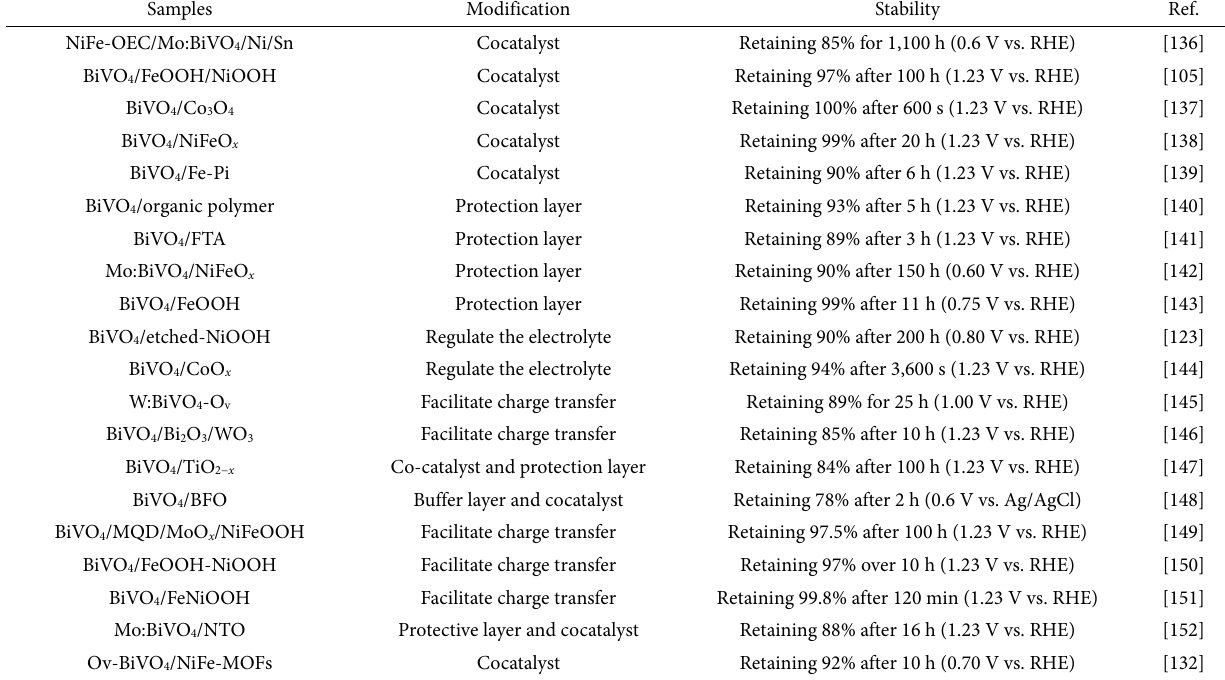
Table 1 The summary of stability research strategies for BiVO 4 Samples